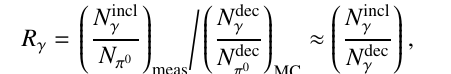
Fig. 2, left, we present the R γ measured in pp collisions at √ s = 8 TeV. It was extracted with 3 di ff erent methods, PCM, EMCAL and hybrid PCM + EMCAL, which are in good agreement within uncertainties and here we present the combined result. At low p T < 4 GeV / c R γ is consistent with unity what means no direct photon excess, but at higher p T